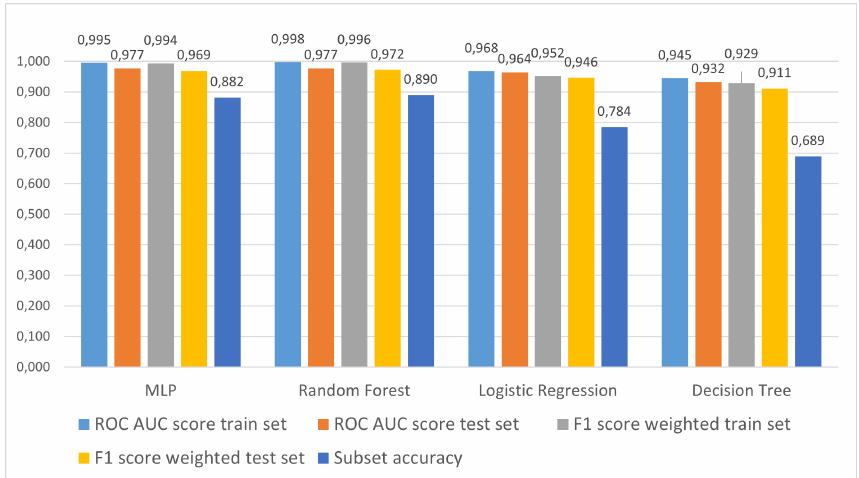
Figure 8. Allergen classifier scores without